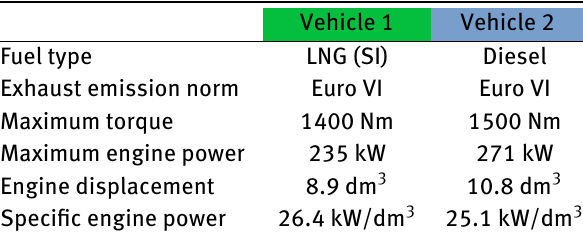
Table 1: Tested vehicles